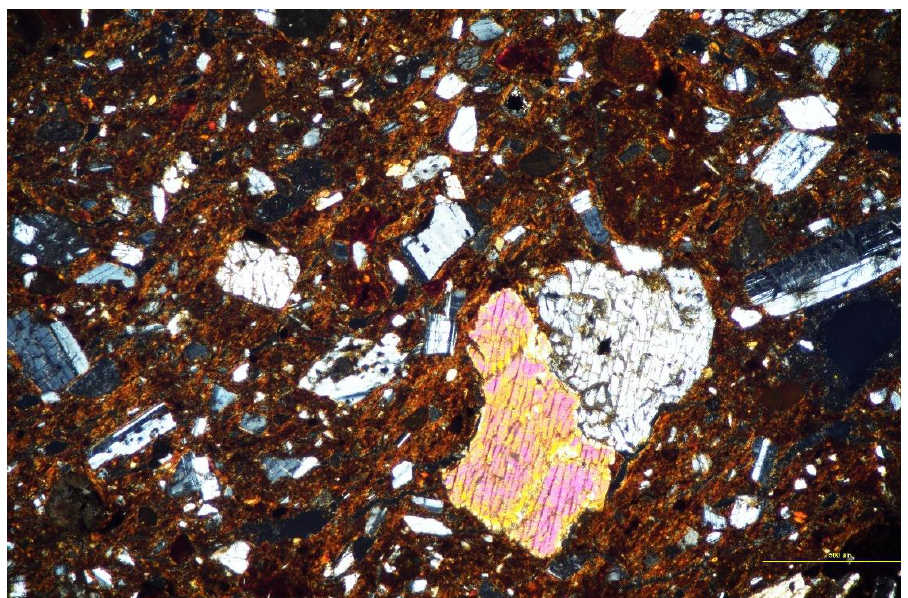
Figure 3. Thin section of a typical Early to Middle Formative pottery fabric with an optically active ground mass (sample FTV502, polarizers crossed). Large minerals depicted include primarily clinopyroxene, orthopyroxene, plagioclase, and volcanic glass. This sample pertains to Group A3 in the current study. Scale bar is 500 μm.